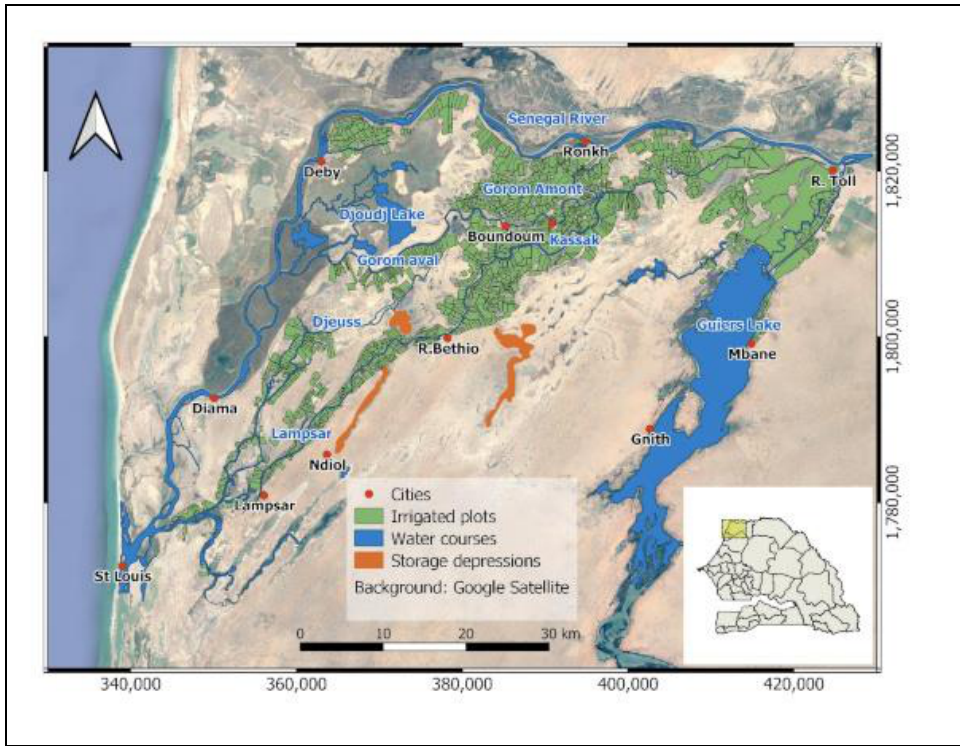
Figure 1. Extension of irrigated plots and water courses in the Senegal River Delta .